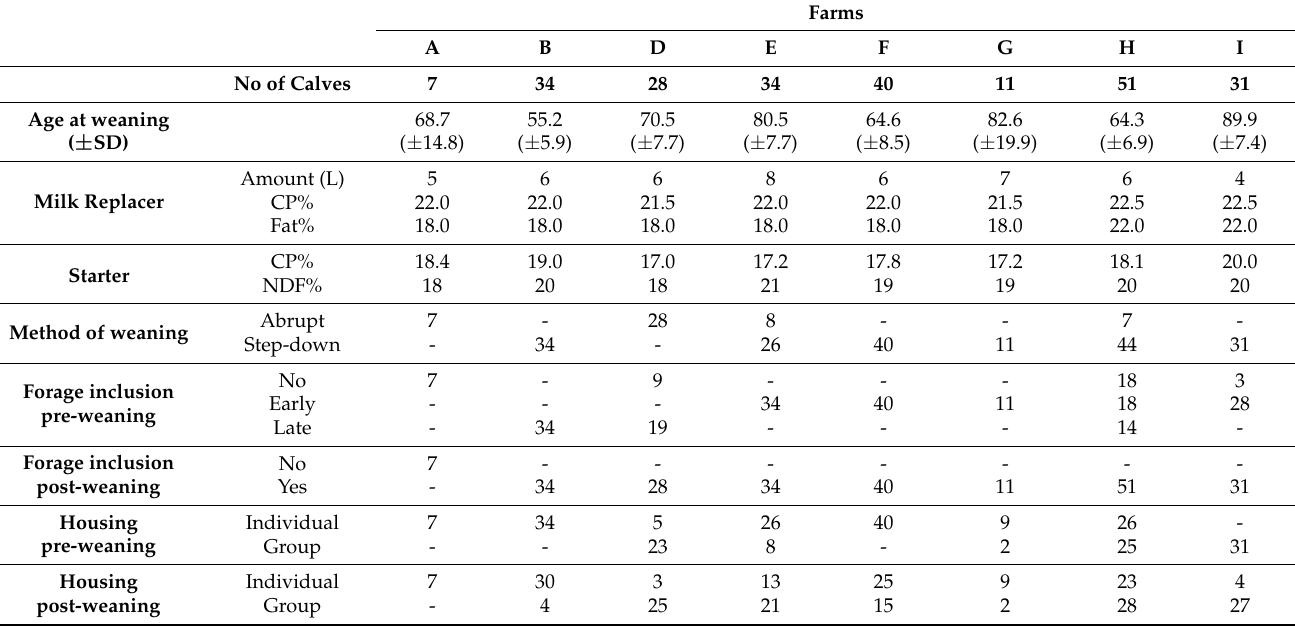
Table 1. Management practices applied in the eight farms participating in the